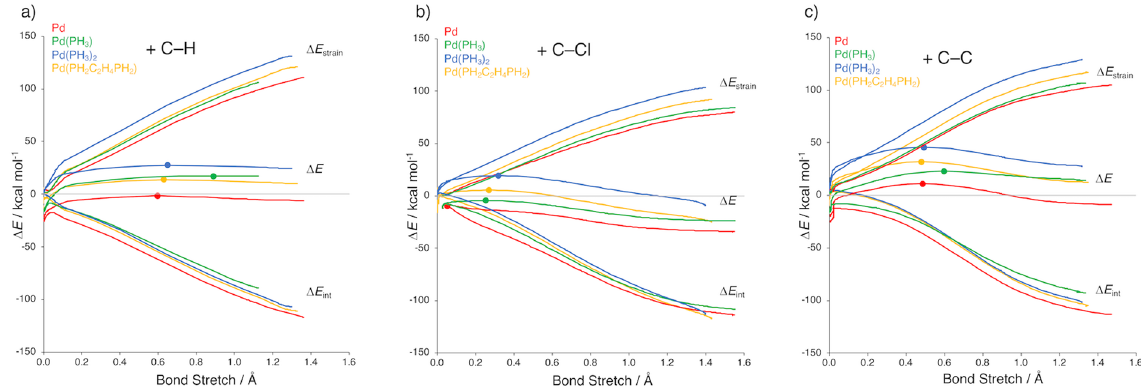
Figure 7. Activation strain diagram comparing the insertion of different catalysts into the ( a ) benzene C–H; ( b ) chlorobenzene C–Cl; and ( c ) toluene C–C, where the transition states are indicated with a dot. Computed at